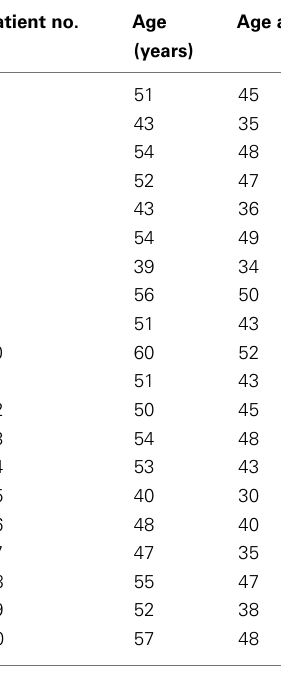
Table 1 | Patient